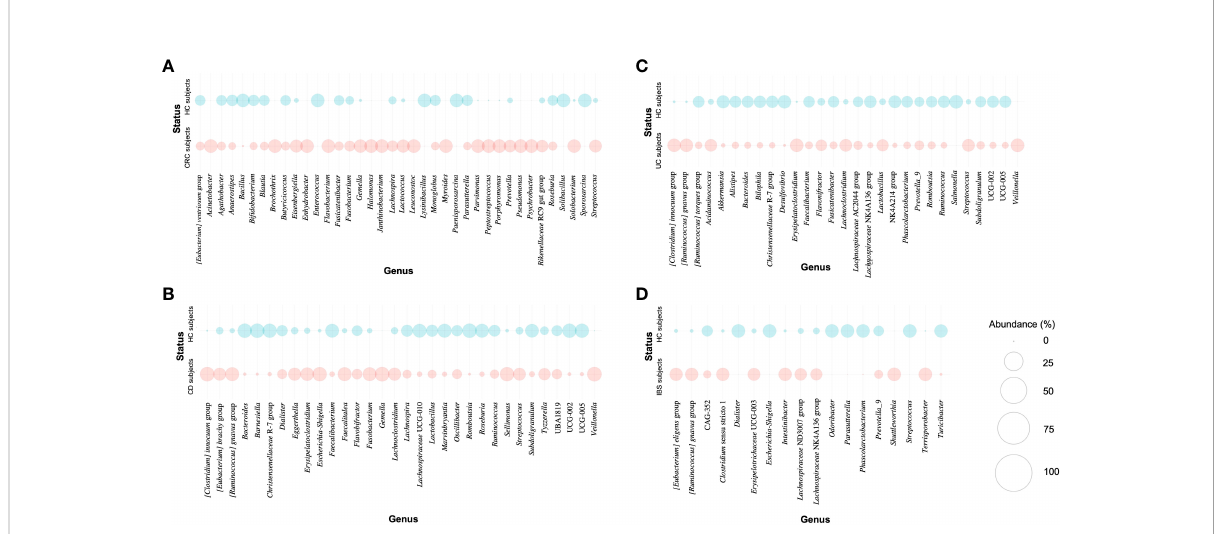
FIGURE 5 Bubble plot for the relative abundance of the genera with a signi fi cantly differential abundance for each study. (A) Differentially abundant genera in CRC subjects and their corresponding controls (HC). (B) Differentially abundant genera in CD subjects and their corresponding controls (HC). (C) Differentially abundant genera in UC subjects and their corresponding controls (HC). (D) Differentially abundant genera in IBS subjects and their corresponding controls (HC). The relative abundance of each genus was calculated by totalizing the number of reads that the genus presented in each of the studies and considering the reads in this group of genera with differential abundance as the